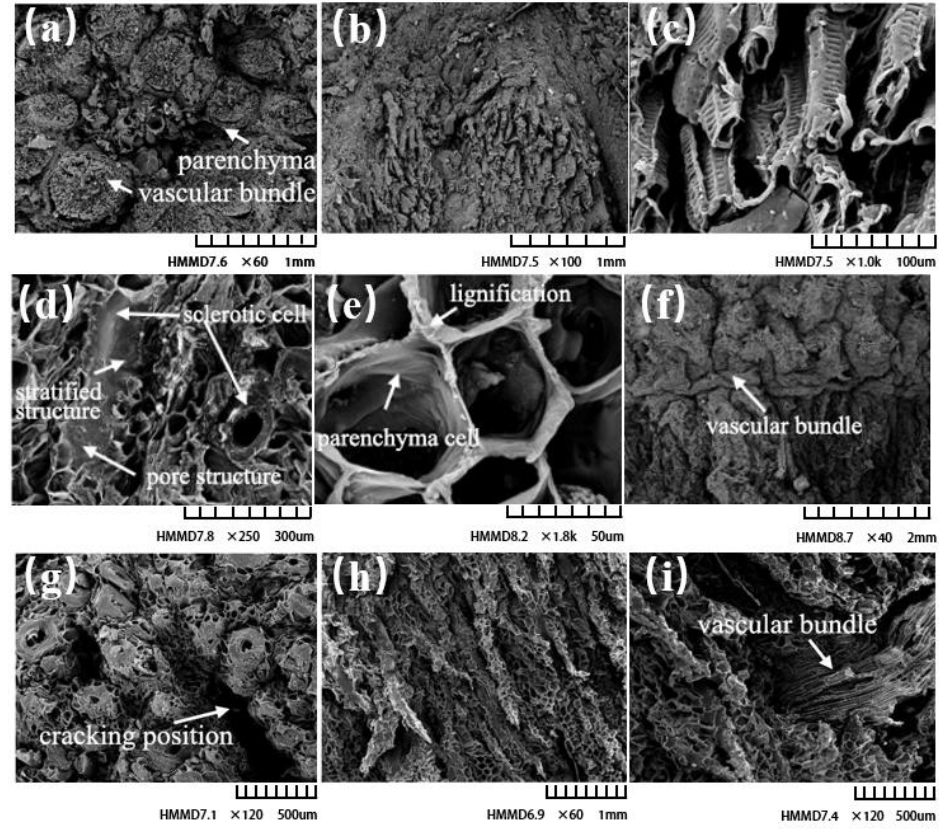
Figure 6. Scanning electron microscopic observation of fruit shell. ( a ) Cross-section at fruit pedicle (60, 1000 μm). ( b ) Longitudinal section at fruit pedicle (100, 1000 μm). ( c ) Vascular structure at fruit pedicle (1000, 100 μm). ( d ) Cross-section at the waist (250, 300 μm). ( e ) Longitudinal section at the waist (18,800, 50 μm). ( f ) Vascular structure at the waist (40, 2000 μ m). ( g ) Cross-section at calyx (120, 500 μm). ( h ) Longitudinal section at calyx (60, 1000 μm). ( i ) Vascular structure at calyx (120, 500 μm).